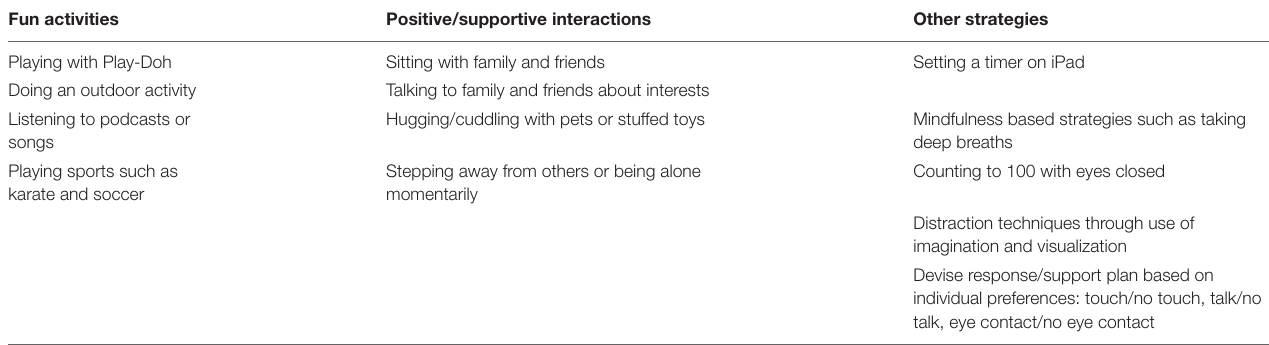
TABLE 4 | Summary of strategies for